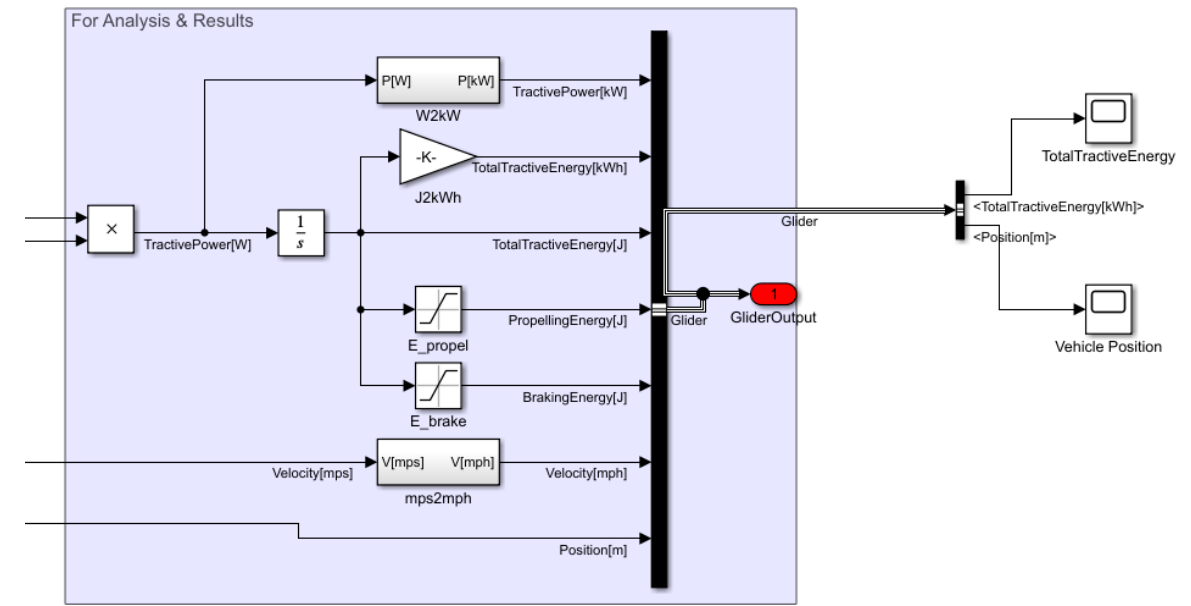
Energies 2021 , 14 , 1493